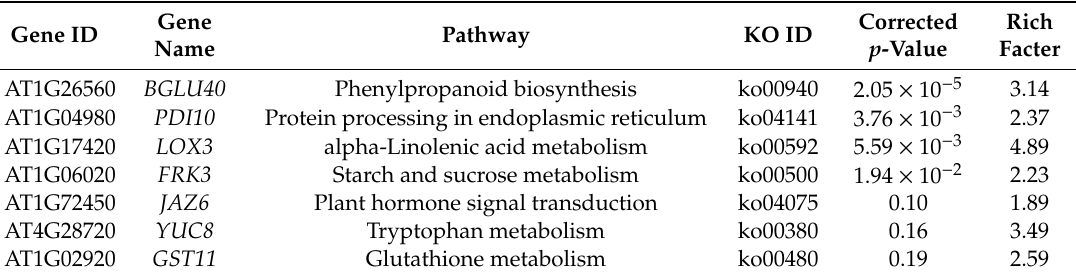
Table 3. Significant representative di ff erentially expressed genes (DEGs) involved in KEGG enrichment during the primary regeneration shoot stage (DWSIM7 vs. DSIM7, DWSIM7 vs. RSIM7, DSIM7 vs. RSIM7).